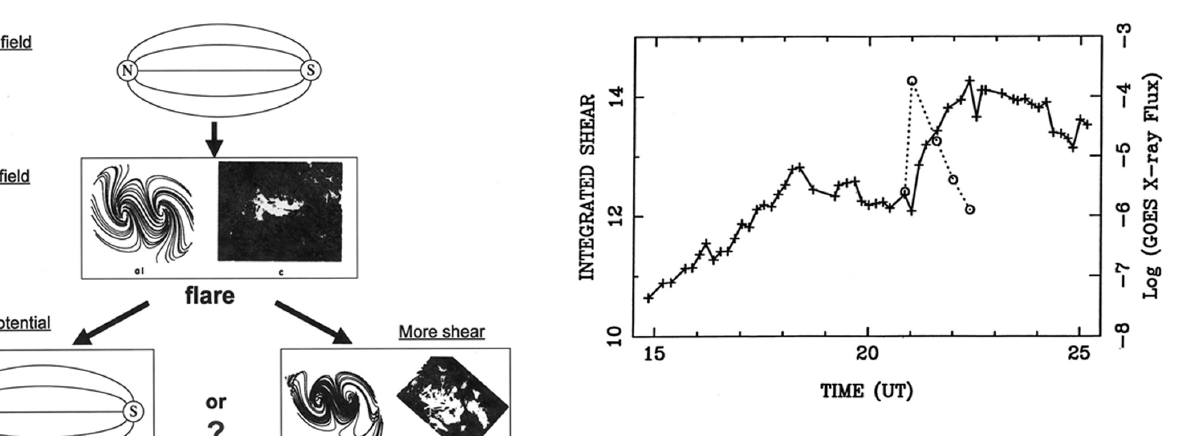
Fig. 20. A typical example of an increase of magnetic shear during a flare (Wang et al., 1994).